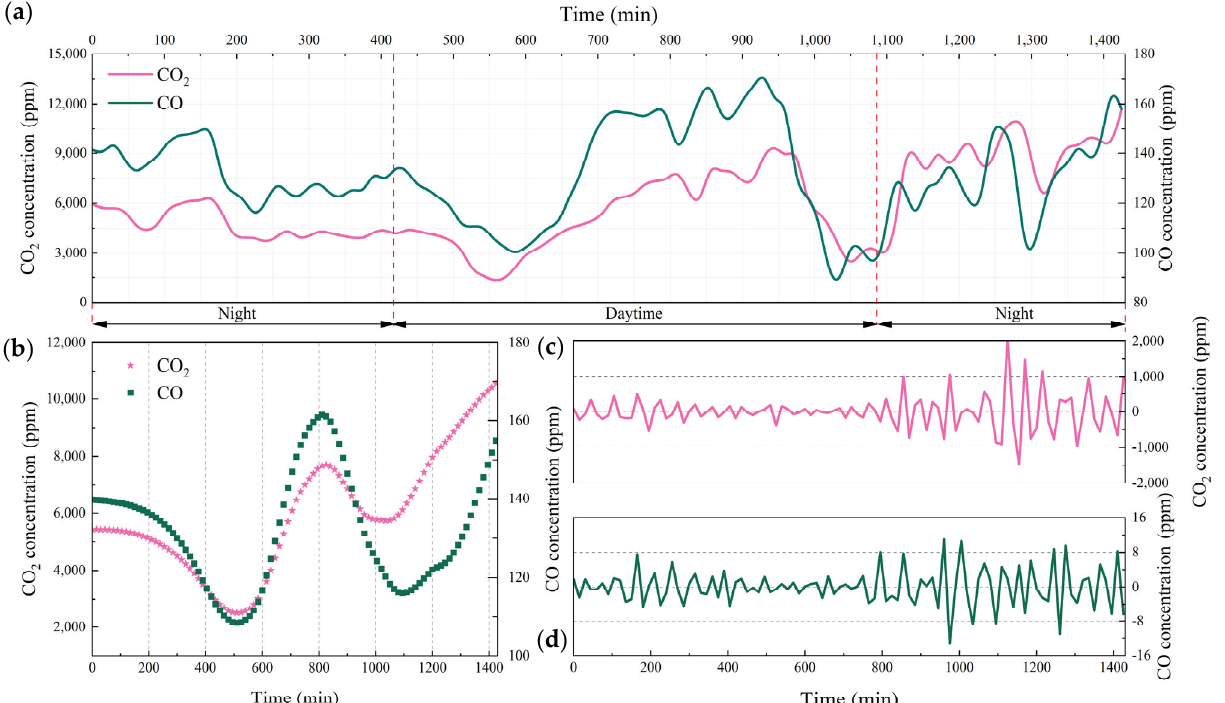
Figure 4. Characteristic diagram of spontaneous combustion gas variation in fissure channel 2# of research point. ( a ) Concentration time change rule; ( b ) Variation characteristics of low − frequency eigenvalues; ( c ) Variation characteristics of high − frequency eigenvalues of CO 2 ; ( d ) Variation characteristics of high-frequency eigenvalues of CO.